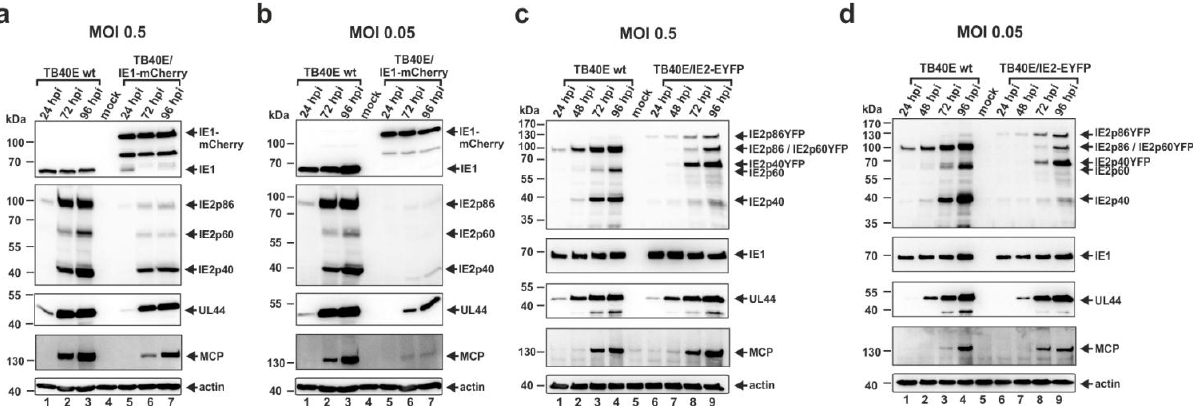
Figure 4. Comparative analysis of viral protein accumulation after infection with wt TB40E and the recombinant viruses TB40E/IE1-mCherry and TB40E/IE2-EYFP. HFFs were infected in parallel with wt TB40E and TB40E/IE1-mCherry ( a and b ) or TB40E/IE2-EYFP ( c and d ) at an MOI of 0.5 ( a and c ) or 0.05 ( b and d ). Cell lysates were prepared at the indicated times after virus inoculation (24, 48, 72 and 96 hpi) and subjected to Western blot analyses. The protein levels of the viral immediate-early (IE) proteins IE1 and IE2, the early-late (E) protein UL44 as well as the true late (L) protein MCP were analyzed using specific antibodies against the respective proteins. Detection of β–actin served as an internal loading control.